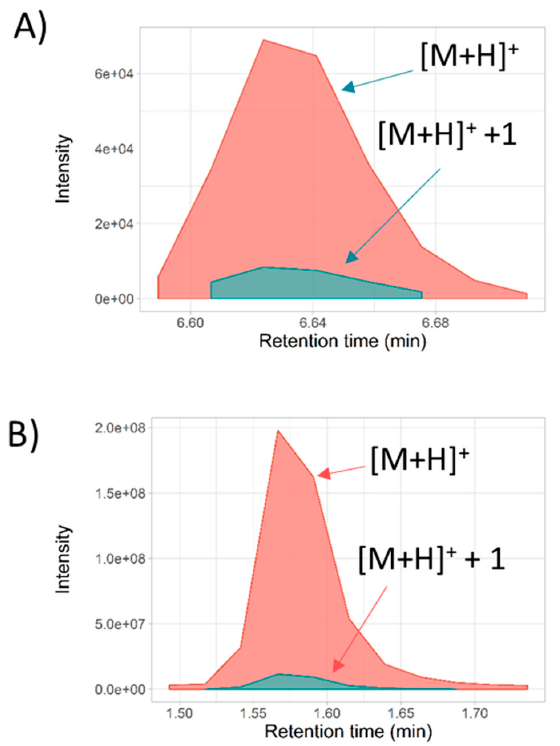
Figure 2. Graphical output generated by the ScoresMS1.R function . ( A ) Coelution extracted ion chromatograms (EIC) (extracted ion chromatogram) profile for phenylacetylglutamine detected in positive ionization mode with [M+H] + and [M+H] + +1 isotope for urine sample analyzed by LC-qTOF. ( B ) Coelution EIC profile for betaine detected in positive ionization mode with [M+H] + and [M+H] + +1 isotope putative identified in cell sample analyzed by LC-q-Exactive Orbitrap.